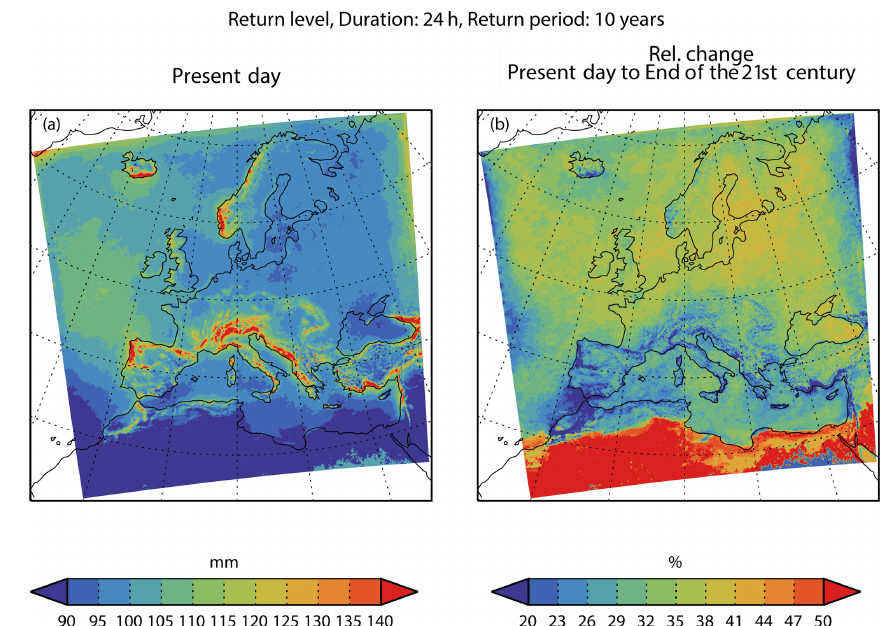
Figure 3. As in Fig. 2 but for a 24h